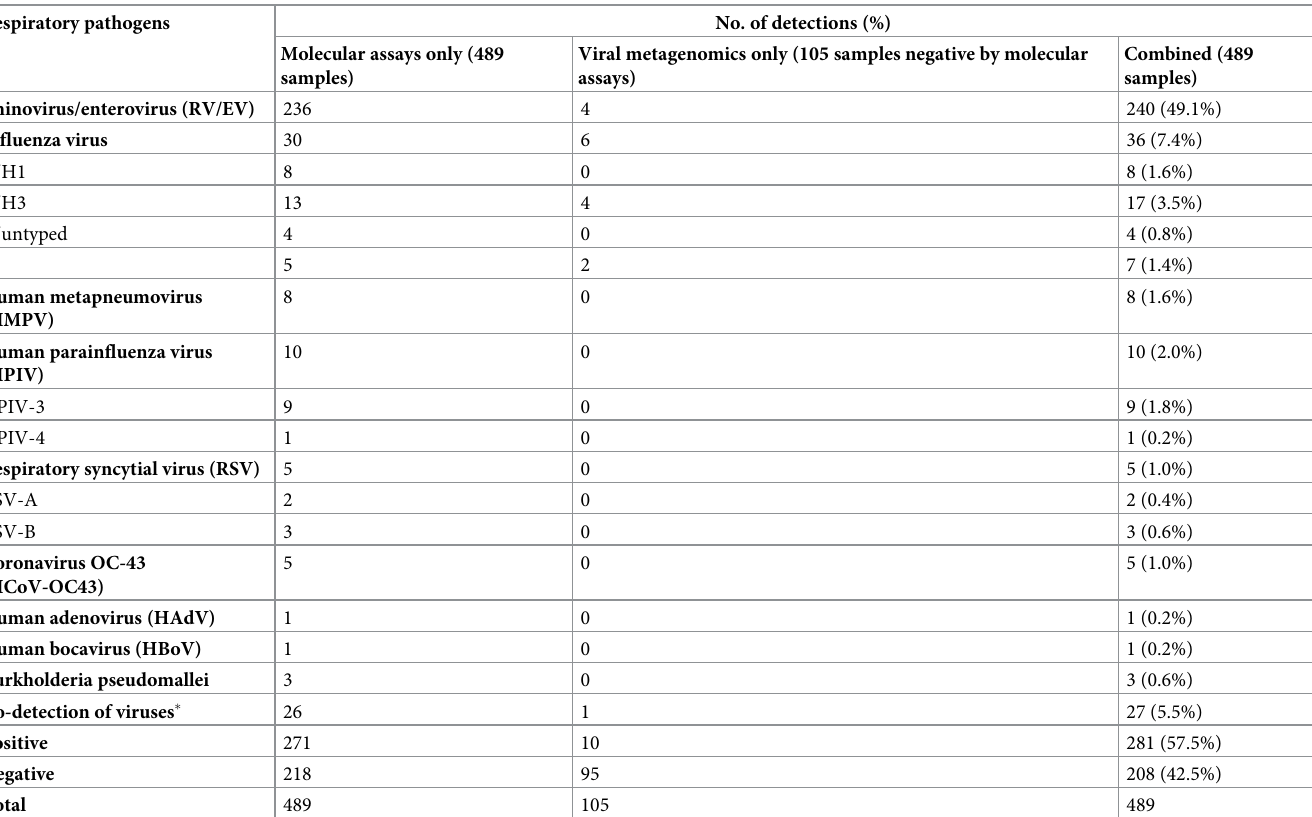
Table 2. Respiratory pathogens detected by molecular assays and next-generation sequencing in clinical